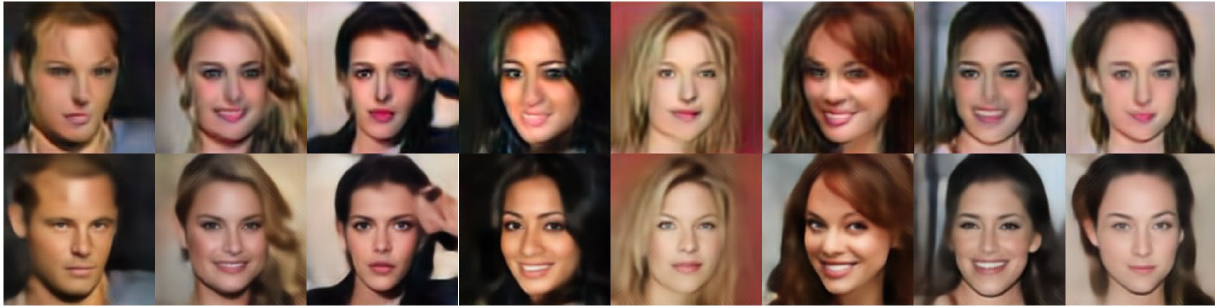
Figure 8. Results: ESRGAN [29] (top row) and proposed method (bottom row).